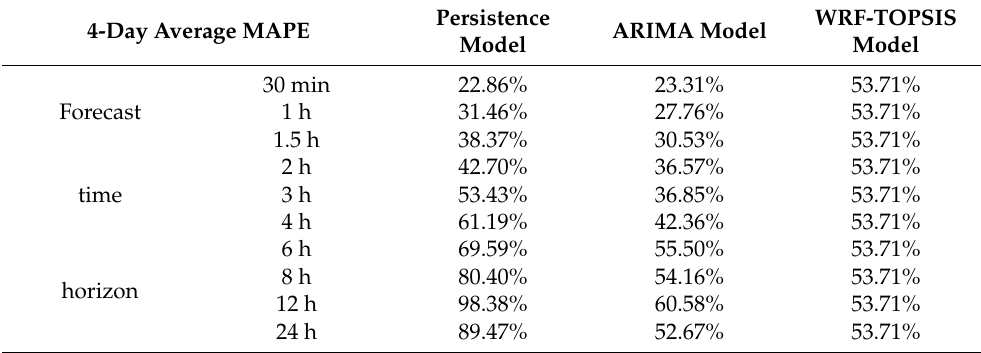
Table 11. Four-day average mean absolute percentage error for the wind speed forecasting using the persistence, ARIMA, and WRF-TOPSIS models applied to the 4-day test dataset.